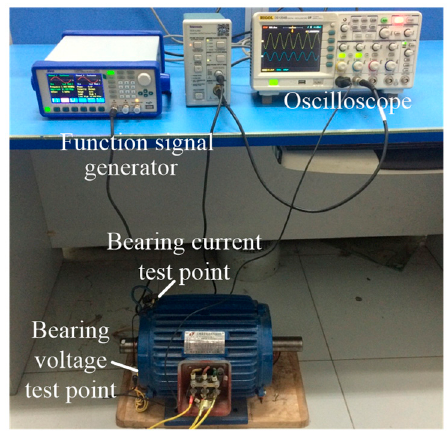
Figure 2. The experimental platform.